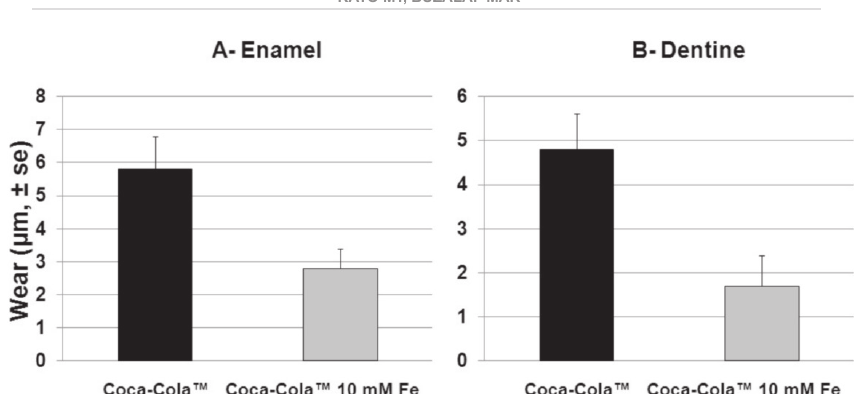
Figure 1- Mean wear of enamel (A) and dentin (B) blocks submitted to erosive challenge in situ by Coca-Cola ™ or Coca- Cola ™ supplemented with ferrous sulfate at 10 mmol/L. Means followed by distinct letters are significantly different (paired t tests, p<0.05). Bars indicate standard error of means